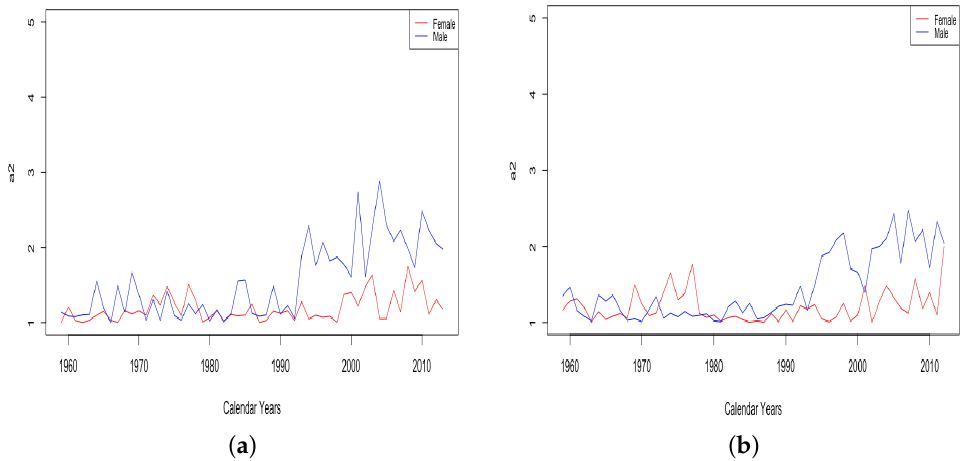
Figure 14. ( a ) Mortality deceleration factor between ages 65 and 85 for Russia, male vs. female. ( b ) Mortality deceleration factor between ages 65 and 85 for Ukraine, male vs. female.